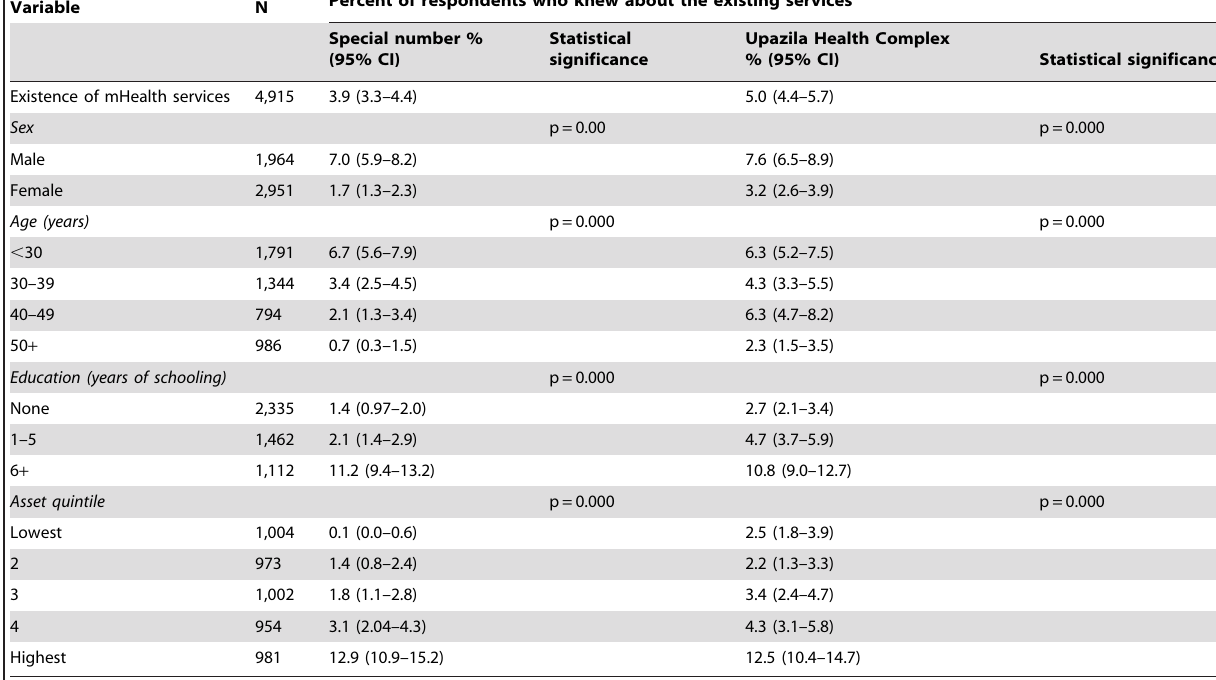
Table 4. Knowledge of existing mHealth services.